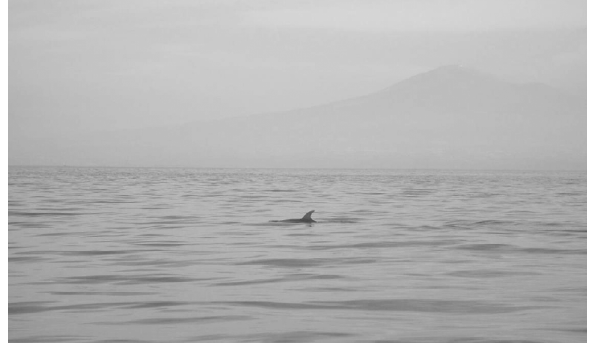
Figure 3. Bottlenose dolphin in the Gulf of Catania with Etna vol- cano shape. (Photo by Ketos association).